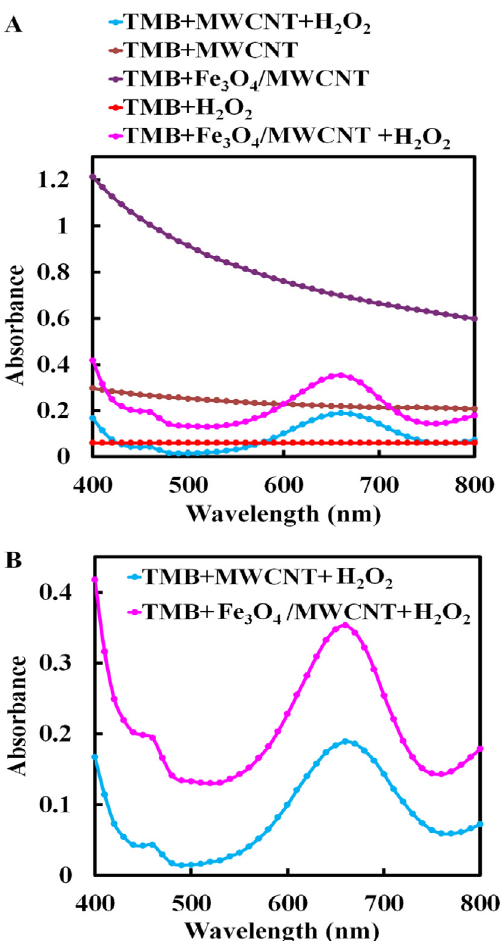
Fig. 7. UV-Vis absorption spectra of the oxidized TMB in Tris solution pH 6 for